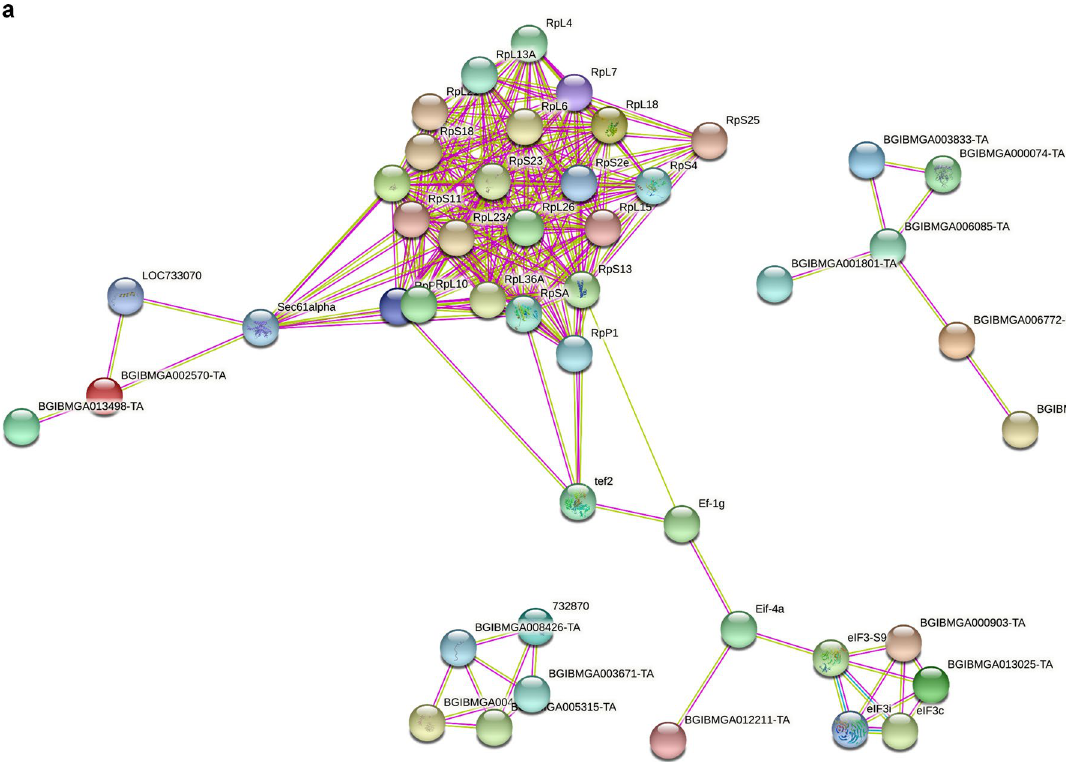
Figure 6. Protein–protein interaction networks among the common PIPs shared by the three fibroin genes. ( a ) The top three significant modules selected from the PPI network generated based on common PIPs from M4. ( b ) The top four significant modules selected from the PPI network generated based on common PIPs from L5D5. Pink or pale green lines represent interaction relationships between the nodes generated based on the available evidence in the STRING database (https:// string- db. org/). Minimum required interaction score: highest confidence (0.900); PPI enrichment p -value: <